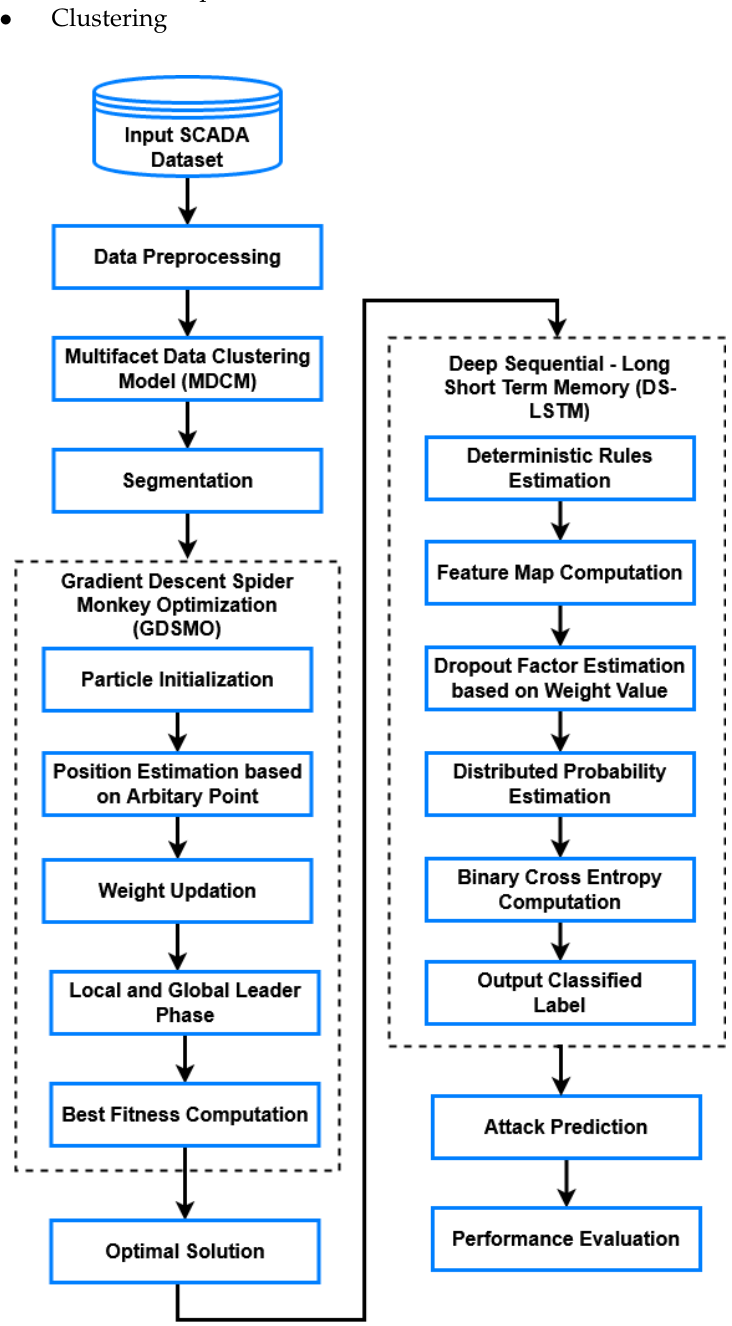
Figure 1. Working flow of the proposed methodology.